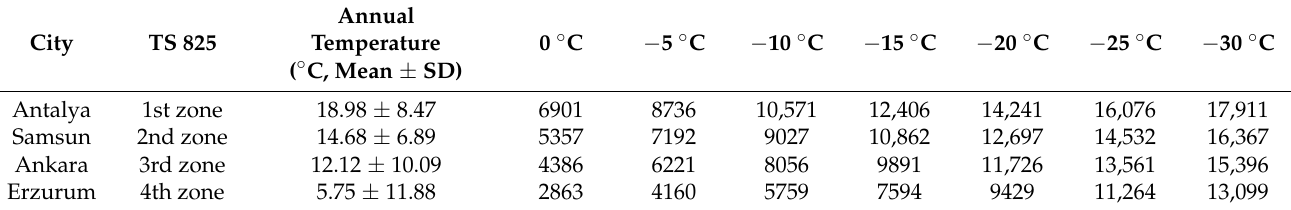
Table 3. Climate zones and CDD values for selected cities.